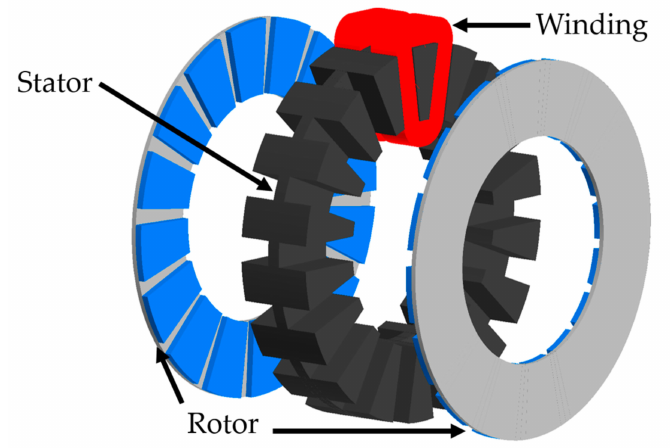
Figure 2. The double-sided axial flux permanent magnet motor.